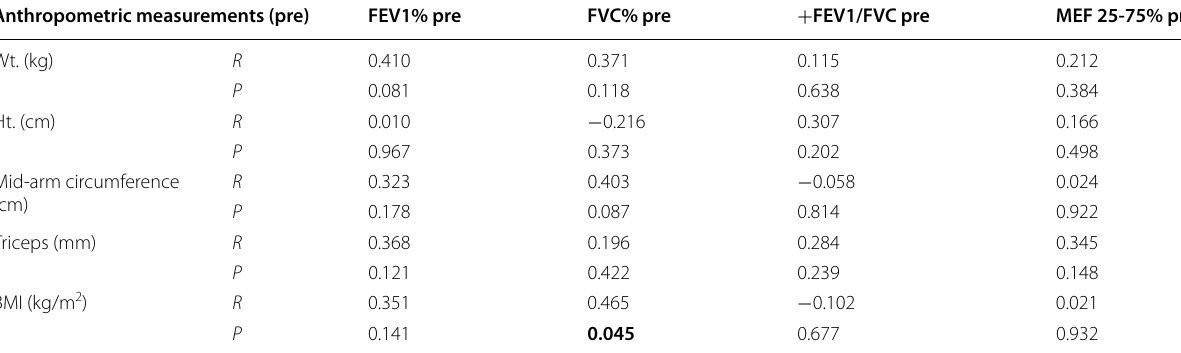
Statistically significant (